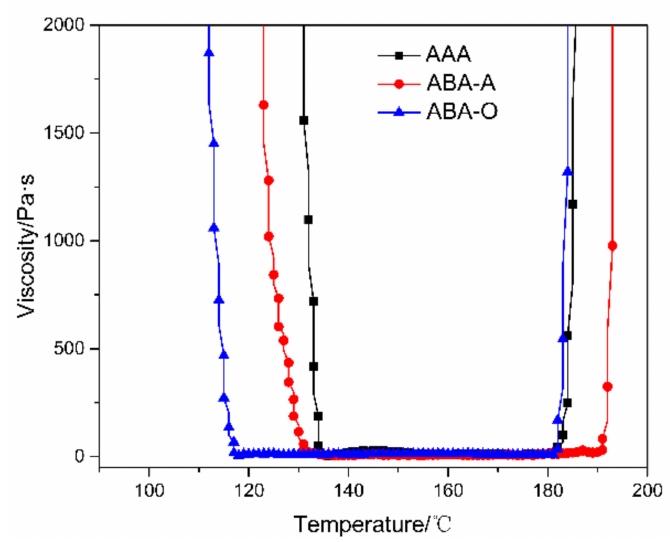
Figure 5. The viscosity–temperature curves of three polymers.